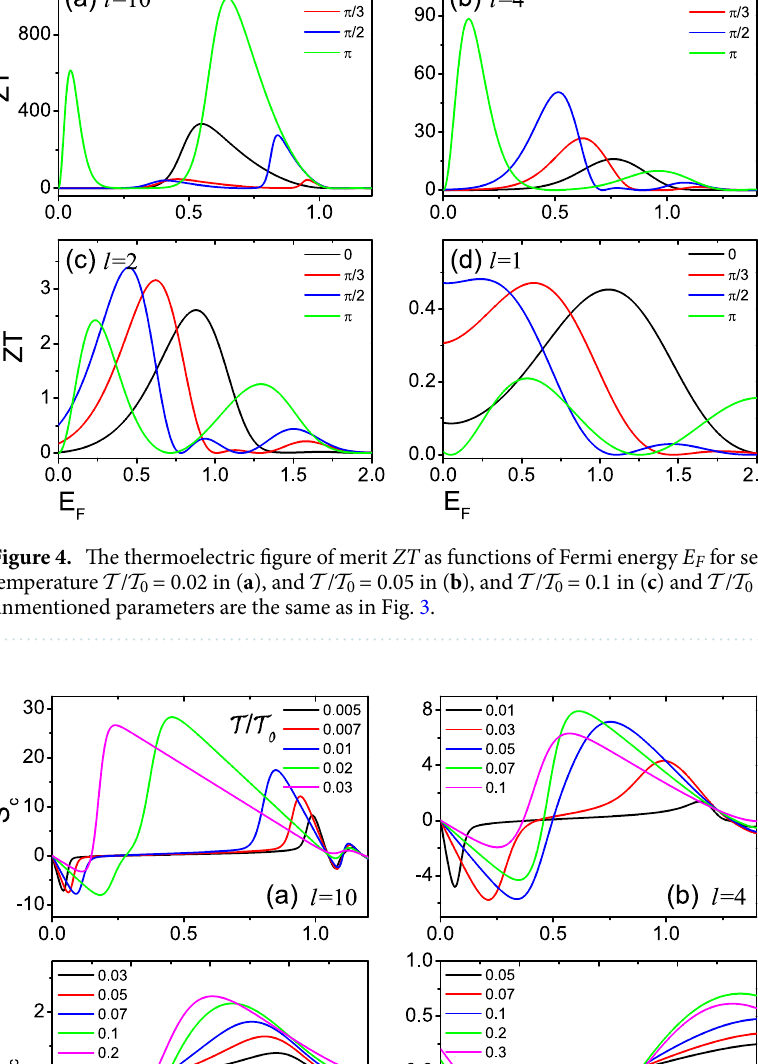
/ k B . Two magnetic domains of equal size l ⊥